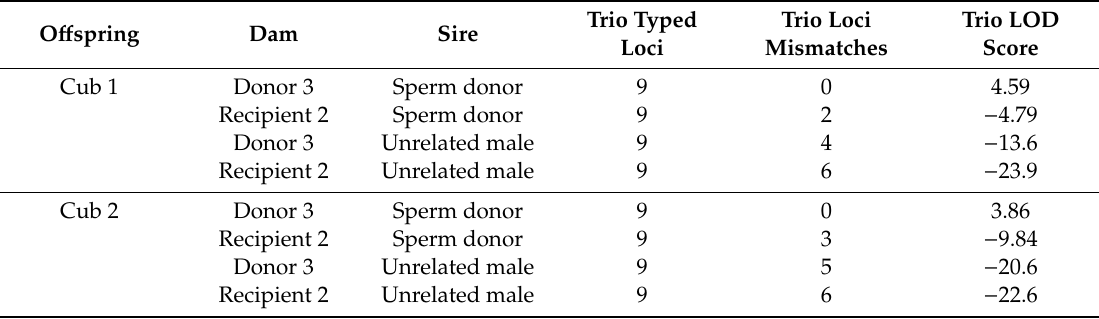
Overall likelihood ratio (LOD score) for each candidate parent and for each o ff spring-dam-sire